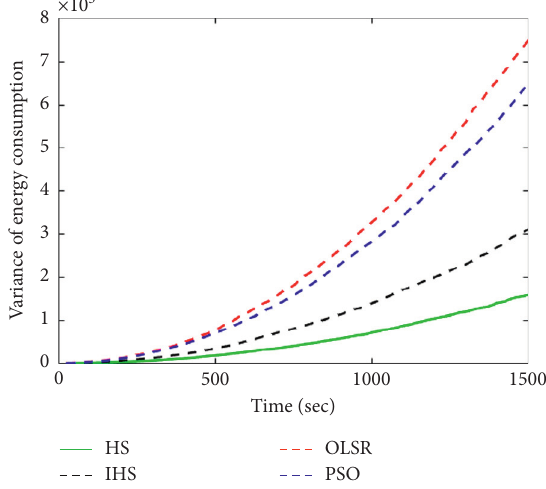
Figure 11: The variance of energy